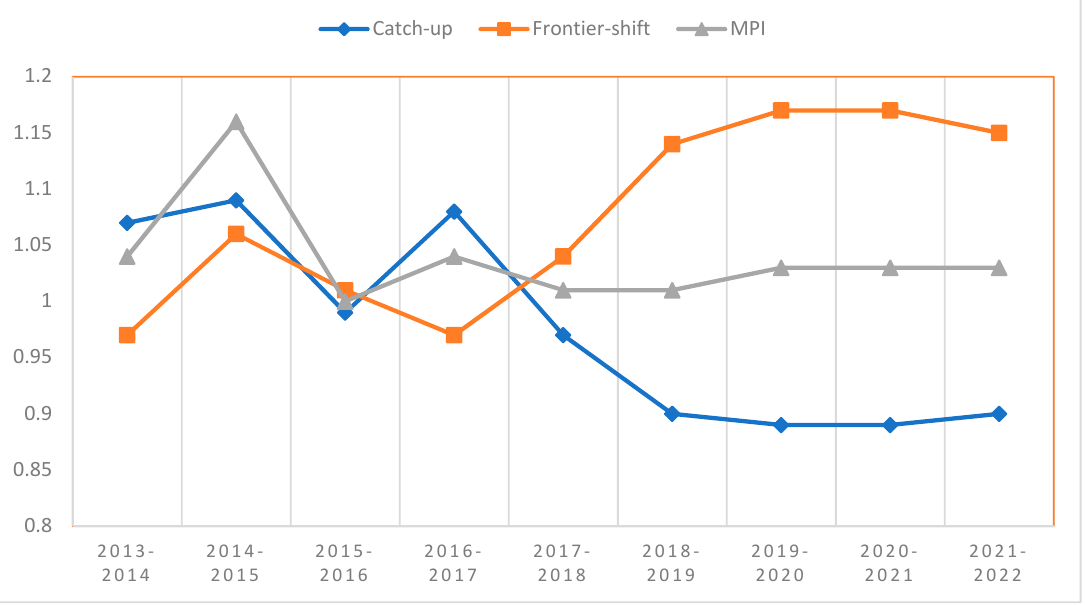
Figure 1. Average mean of MPI change of information and communication technology (ICT) industry.